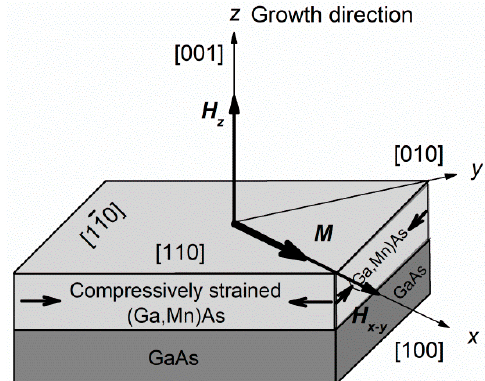
Figure 3. Coordinate system used in this paper. The initial magnetization lies in the plane of the sample along [100] direction. The [100] direction, [010] direction and [001] direction are defined as the directions of x axis, y axis, and z axis, respectively. The magnetic anisotropy field H x-y is in the plane of the film, and the magnetic anisotropy field H z is out of the plane of the film. The arrows in (Ga,Mn)As layer represent the direction of compressive strain in the plane.